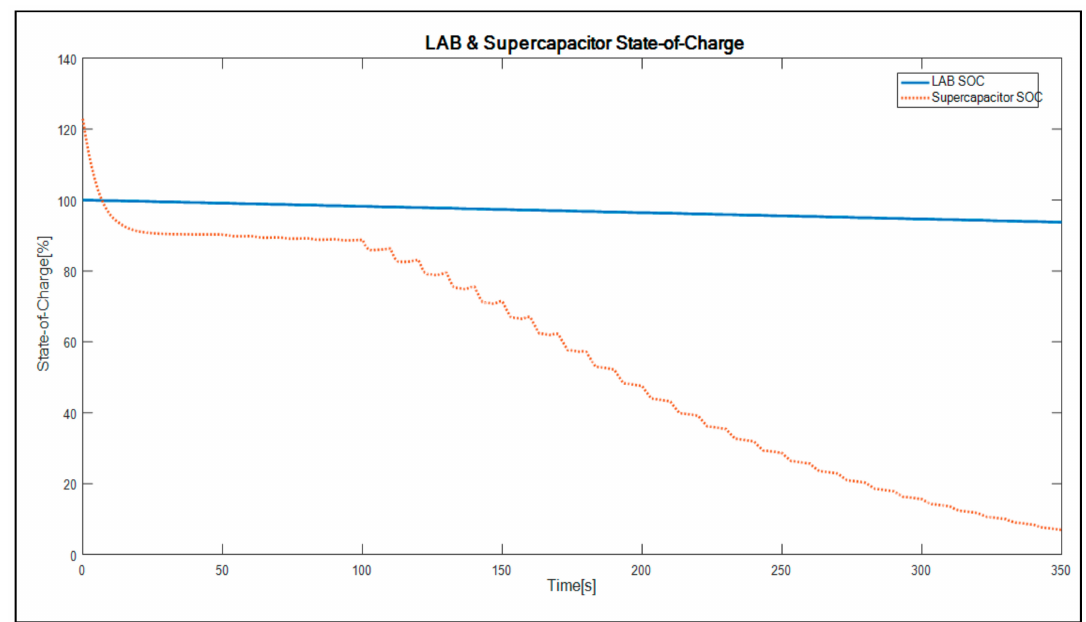
Figure 12. Lead acid battery state-of-charge and supercapacitor state-of-charge